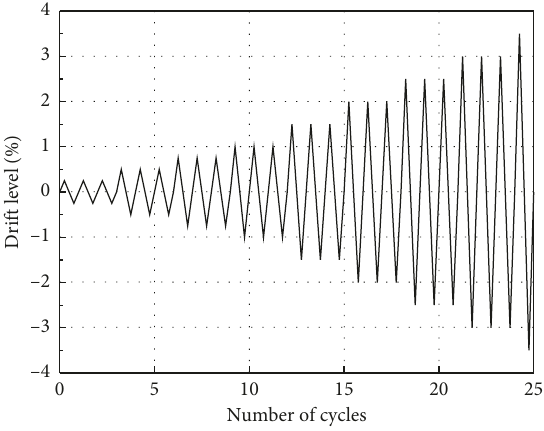
Figure 3: Loading cycles for wall